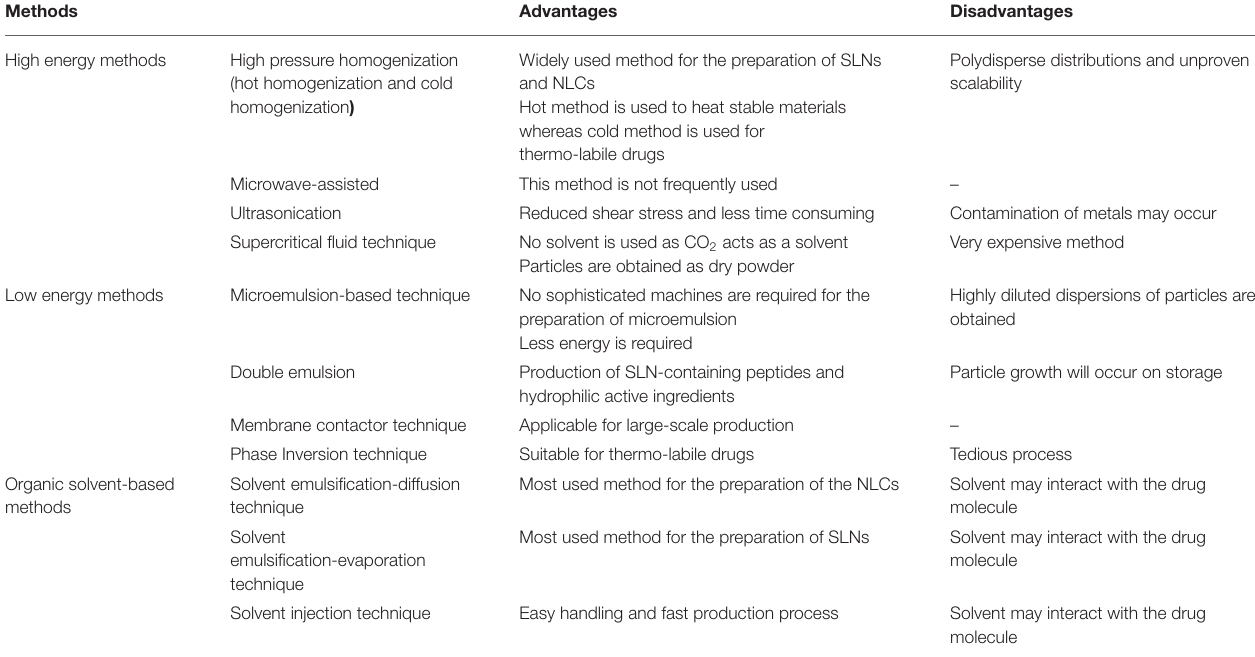
TABLE 1 | Methods for the preparation of SLNs and